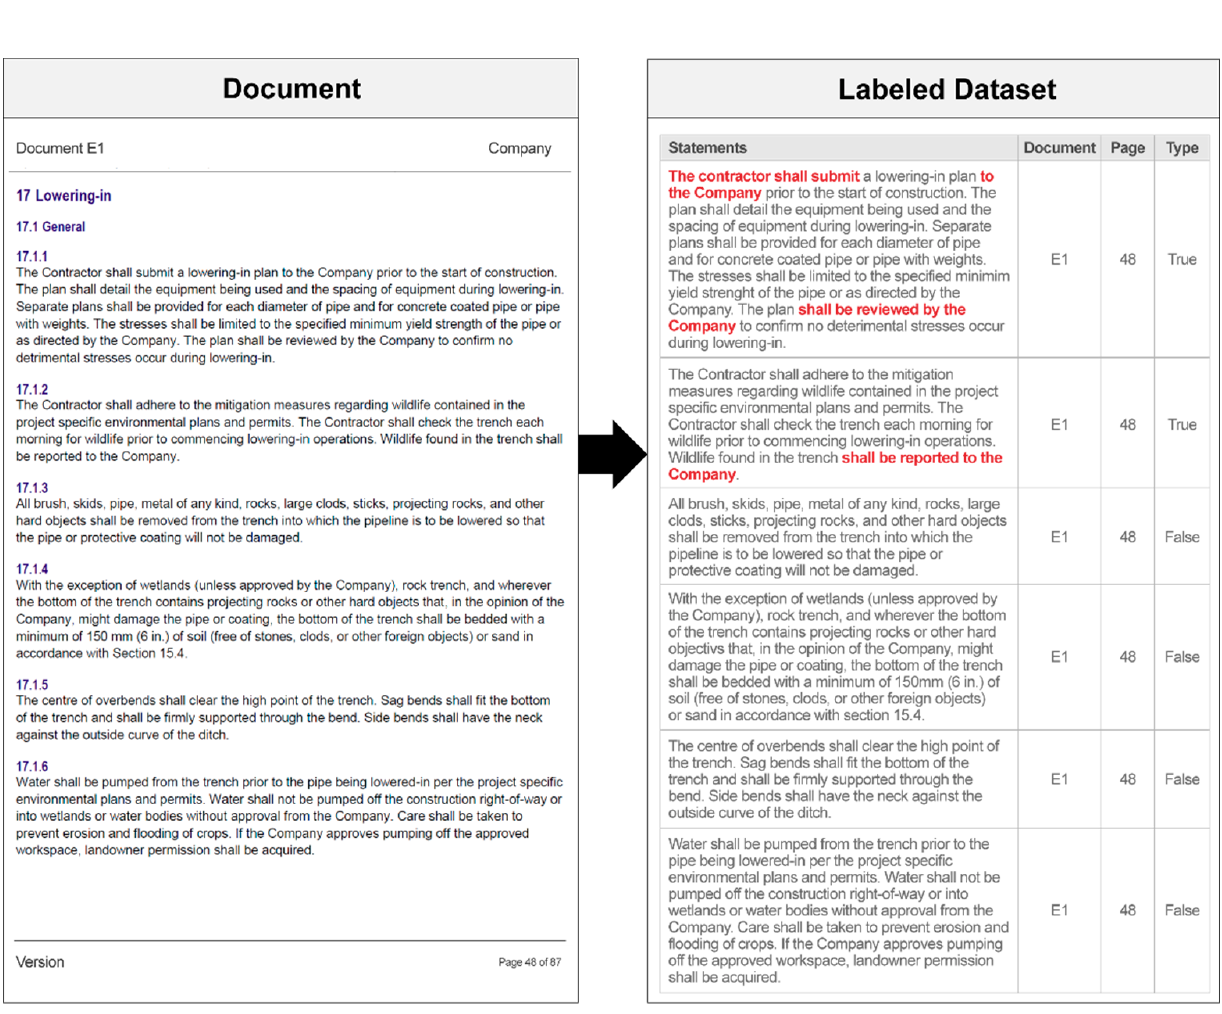
Figure 3. Sample contract document (left) and labeled dataset (right).